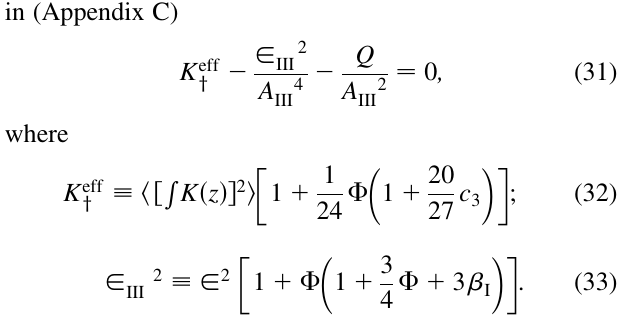
FIG. 2. Illustration of matched envelopes a (cid:1) z (cid:2) and b (cid:1) z (cid:2) for special case of FODO model. Parameters from Table II, giving (cid:3) 112 : 2 (cid:10) ; (cid:2) (cid:3) 86 : 9 (cid:10) . Exact envelopes (solid curves) tunes (cid:2) 0 obtained numerically. Third-order results from Eqs. (30), using error of (cid:4) 2 : 37% . Smooth approxi- Eqs. (E6)–(E10), give a max mation error [Eq. (E6) only] is (cid:4) 13 : 0% . Amplitude of half- period ripple is 5 : 6% of amplitude of full-period